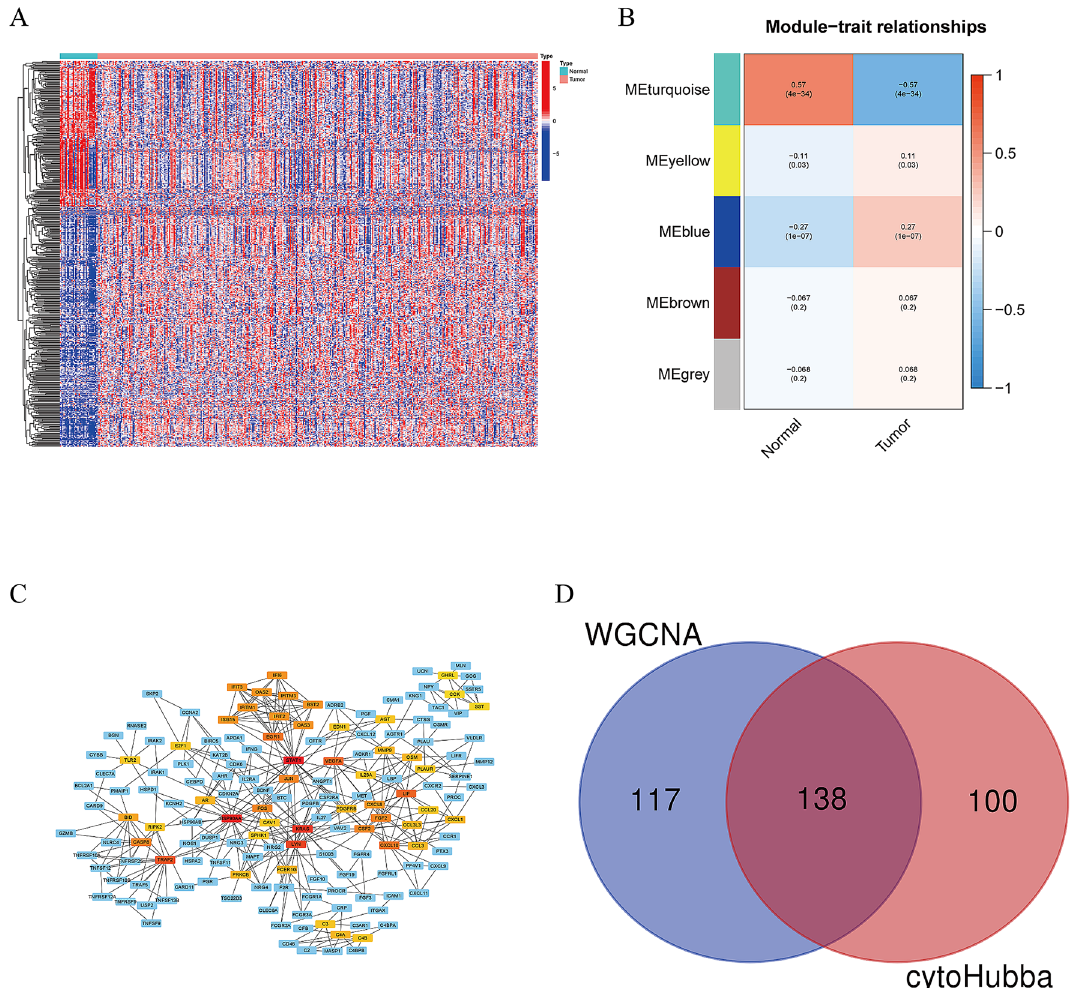
Figure 1. Selection of immune-related genes. ( A ) Heatmap showing differential immune-related gene expression between normal and gastric cancer tissues ( B ) Heatmap of the correlation between normal and tumor tissues on module genes. ( C ) PPI network diagram of immune hub genes. ( D ) Venn diagram shows the immune-related genes. [Figures created by R, version 4.0.4. STRING, https:// string- db. org/; Cytoscape (https:// cytos cape. org/; version